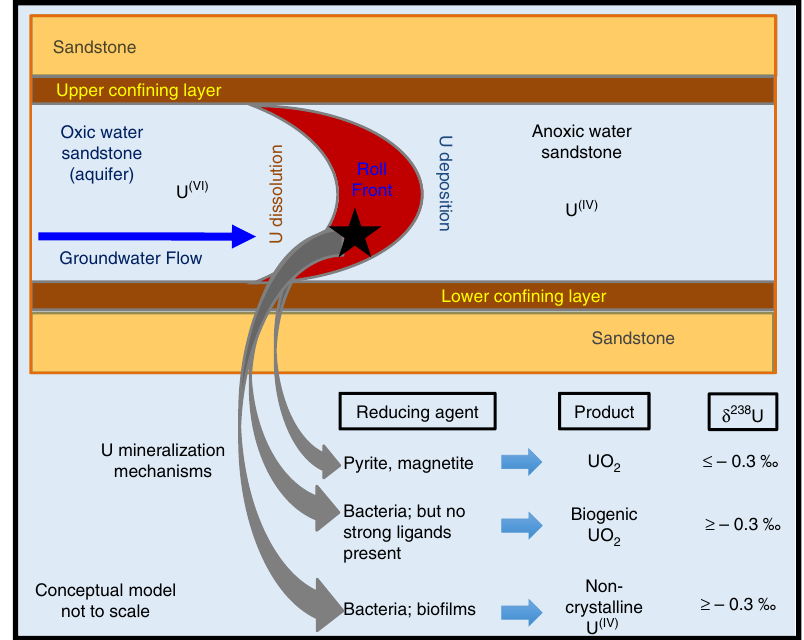
Figure 4 | Conceptual model of uranium roll-front deposit formation. Precursors and conditions favouring the formation of uraninite, biogenic uraninite and non-crystalline U (IV) are